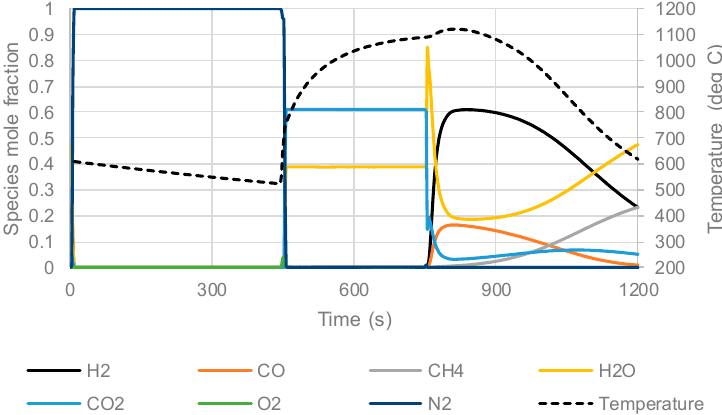
Figure 6. Outlet gas species composition and temperature during one PBCLR cycle with 2 × higher gas feed over 4 × larger particles than in Figure 4.